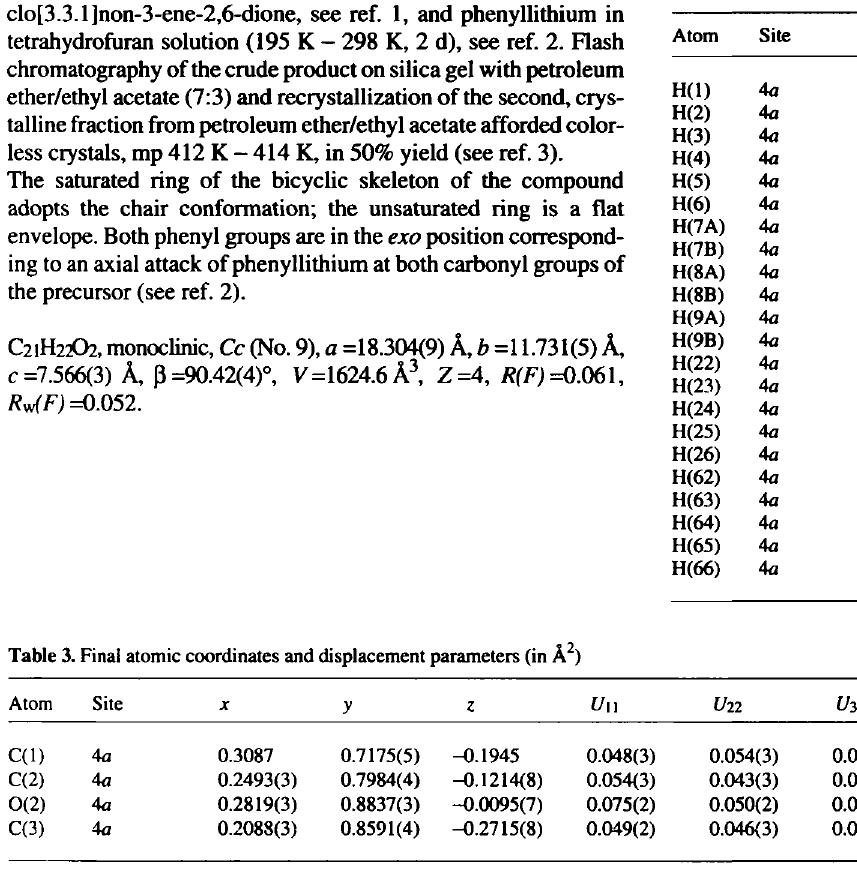
Table 2. Final atomic coordinates and displacement parameters (in Â^)